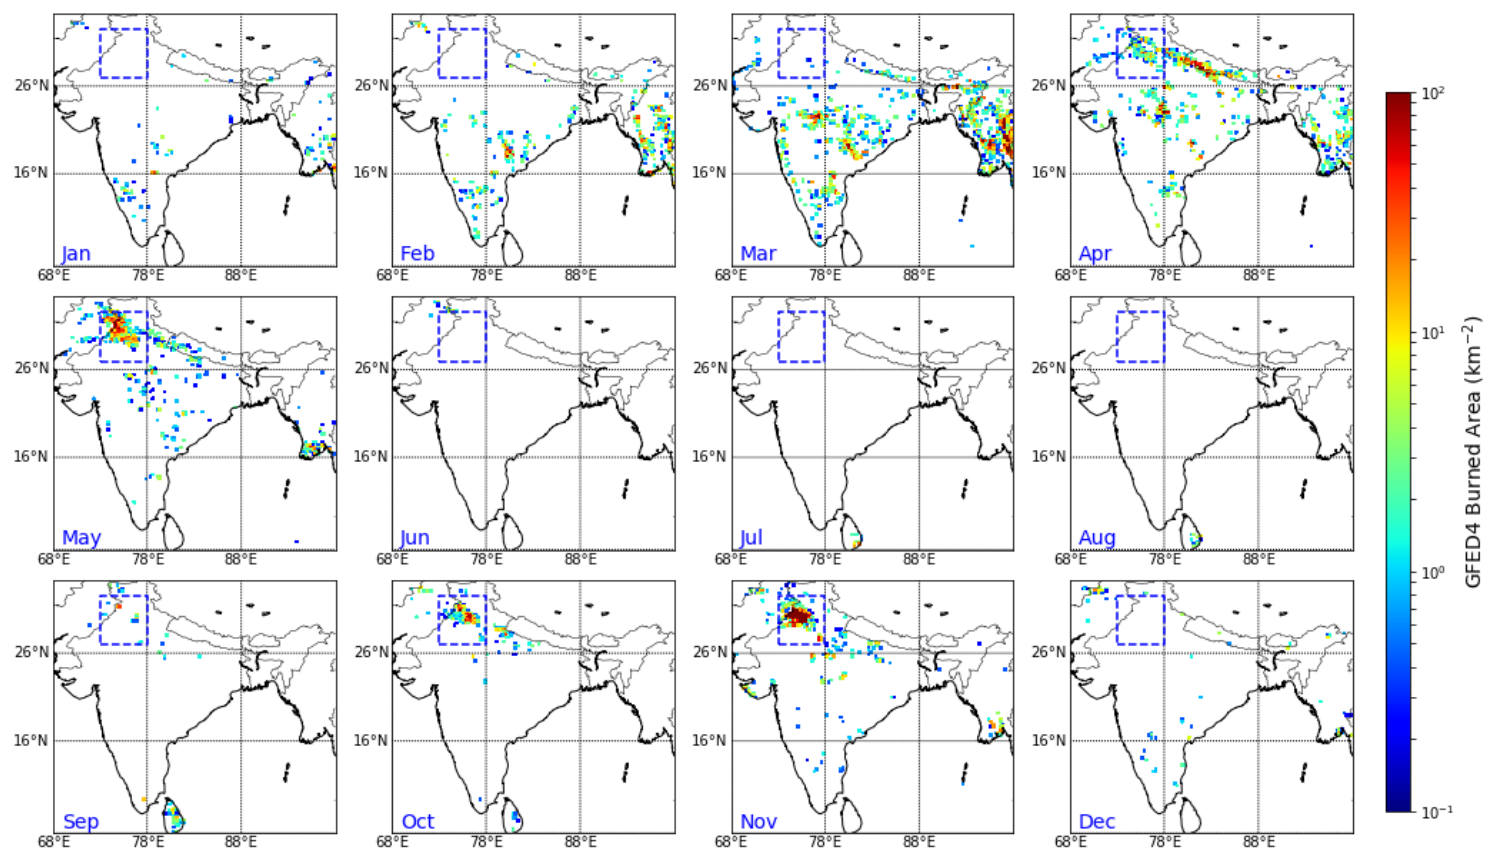
Figure 2. Monthly burned area (0.25°) reported for 2016 across India by the MCD64A1 product, as derived from 500 m MODIS observations using the algorithm of [4] and reported by GFED4. In Punjab, north-western India (highlighted by the blue rectangle) fire shows a strong seasonal pattern, with activity occurring primarily in May and then again (stronger) in October and November. These periods are associated primarily with agricultural fires, with wheat stubble primarily burned in May and rice straw in October–November.